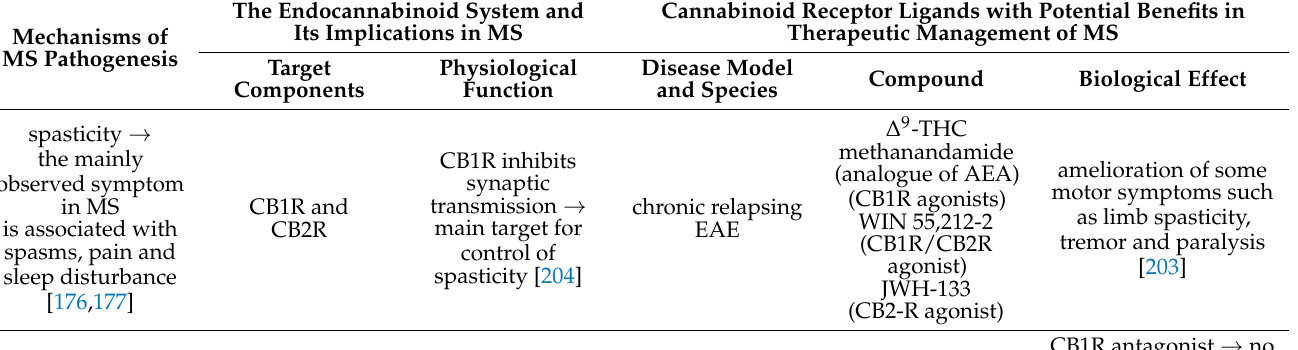
Table 4. Implications of ECS in various pathological aspects of MS; ↓ : decrease;  ↑ =